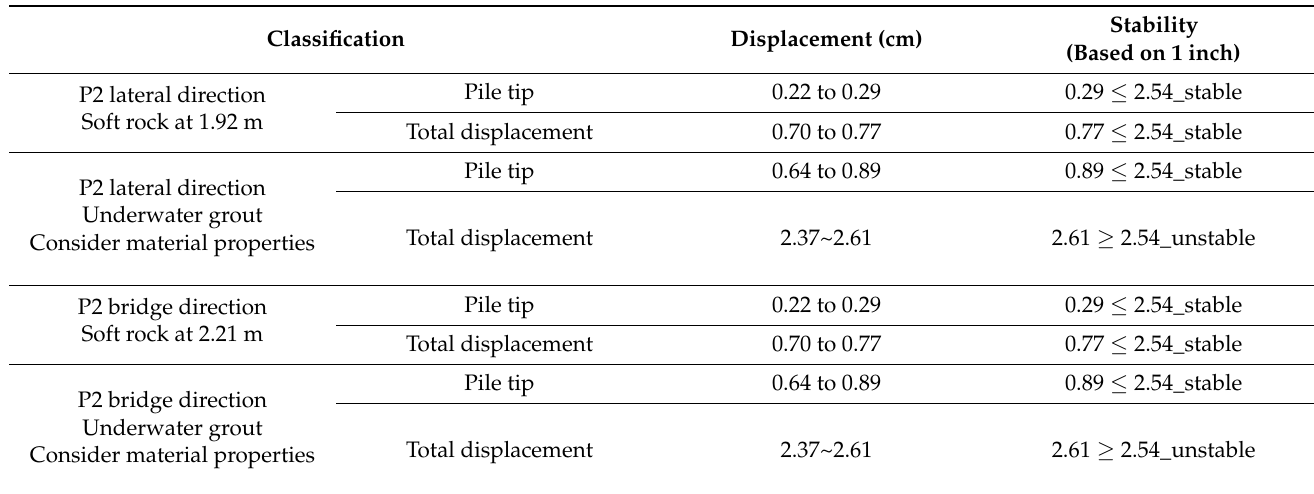
Table 11. Numerical analysis